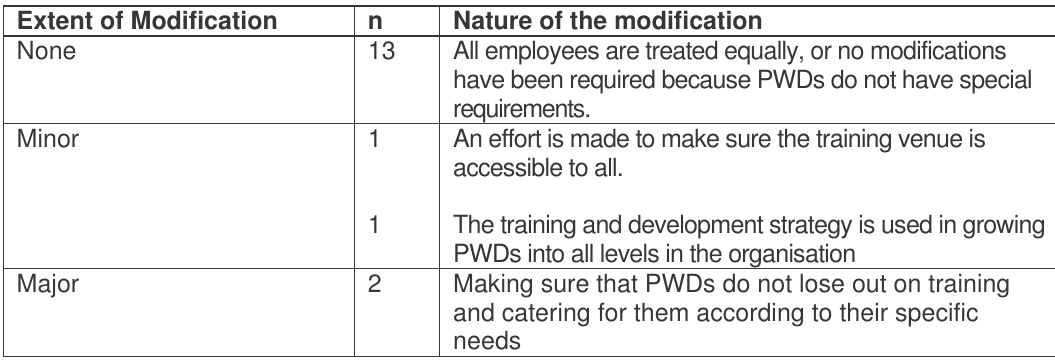
Table 6: Training and career development Extent of Modification